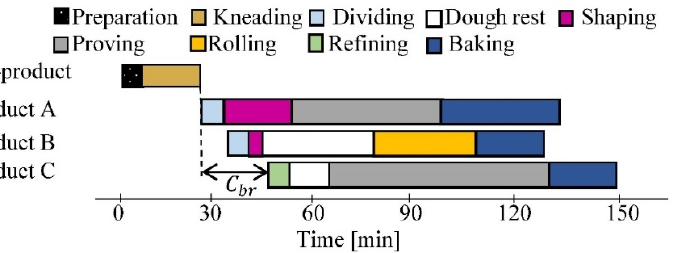
Figure 3. A schedule for a simplified group of products that share the same dough. C br shows the bowl resting time for product C.